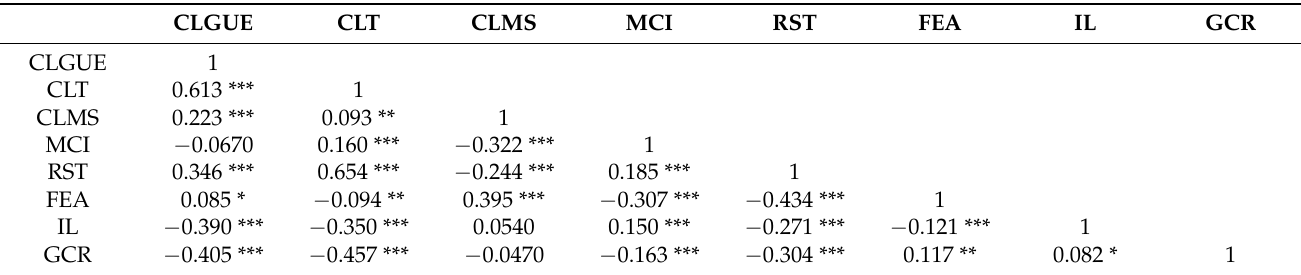
Table 3. Correlation Analysis of Variables.